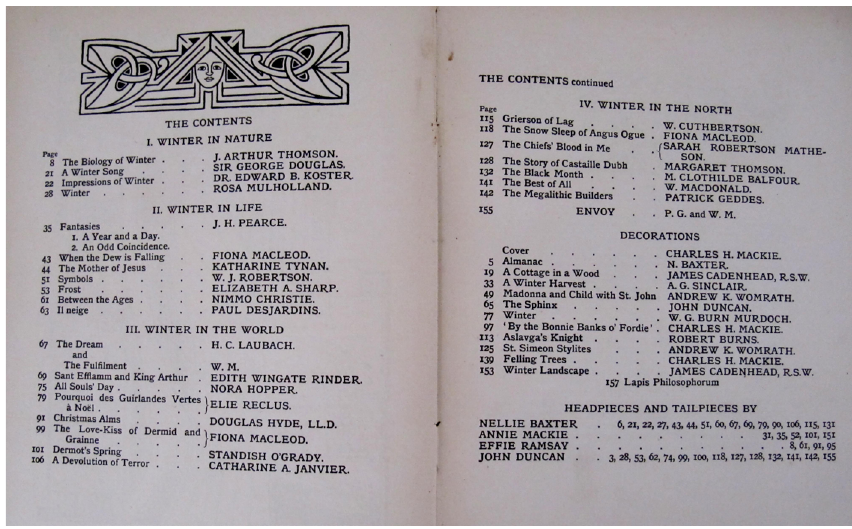
Fig. 2b Evergreen: A Northern Seasonal (Winter 1896–97), double-paged table of contents, private